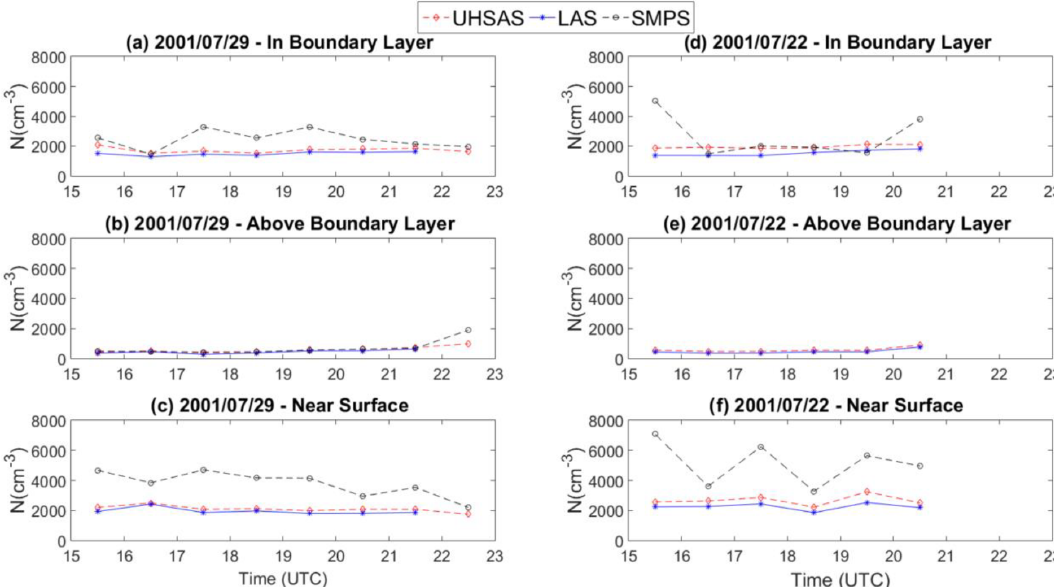
Figure 12. Hourly mean values of mass of the different species that form aerosol particles measured by the P-3B airplane on 29 and 22 July 2011. Data are presented for three different altitudes: near the surface (altitude below 1km), in the planetary boundary layer (1–2km for 29 July and 1–1.8km for 22 July) and above the planetary boundary layer ( > 2 . 0km for 29 July and > 1 . 8km for 22